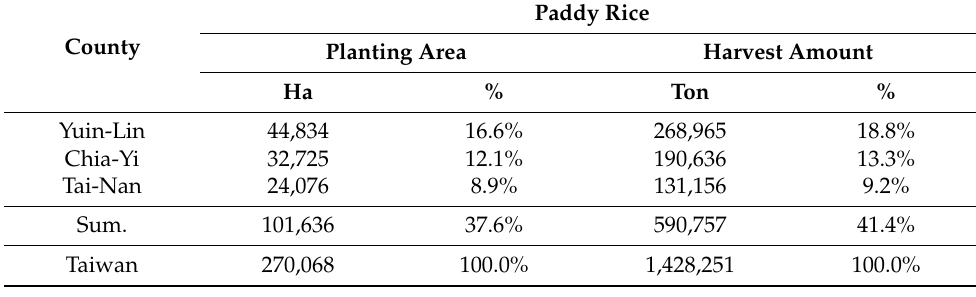
Table 1. The planting area and yield in the study area.